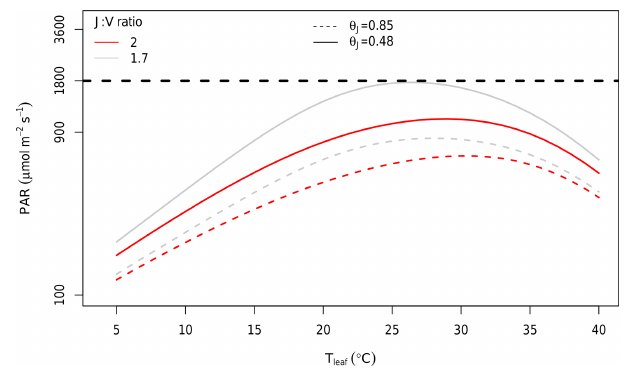
Figure 7. Estimated PAR value at which limitation to photosyn- thesis shifts from RuBP regeneration to Rubisco at different leaf temperatures and J : V ratios. Rubisco limitation occurs at PAR values above the curves; RuBP regeneration limitation occurs be- low the curves. The curves were calculated using the Photosyn function in the plantecophys R package (Duursma, 2015). Param- eters other than PAR and T leaf were assumed to be constant: C a of 390µmolmol − 1 , D of 1.5kPa, g 1 of 3.3kPa 0 . 5 , and V cmax , 25 of 90µmolm − 2 s − 1 . The temperature and light dependences of pho- tosynthesis were assumed to be the same as in MAESPA. The grey line was predicted by assuming J max , 25 = 153µmolm − 2 s − 1 (i.e. a J : V ratio of 1.7). This J : V ratio was observed consistently in Eu- cFACE across campaigns and rings. The red line was predicted by assuming J max , 25 = 180µmolm − 2 s − 1 (i.e. a J : V ratio of 2). This J : V ratio has been commonly reported and used in other studies. The horizontal dashed line shows the PAR = 1800µmolm − 2 s − 1 at which leaf-level measurements of EucFACE were made. Note the log scale of the y axis. The dashed curves are based on quantum yield of electron transport ( α J ; molmol − 1 ) and the convexity of light response of RuBP, θ J , unitless values from the CABLE model (Haverd et al.,